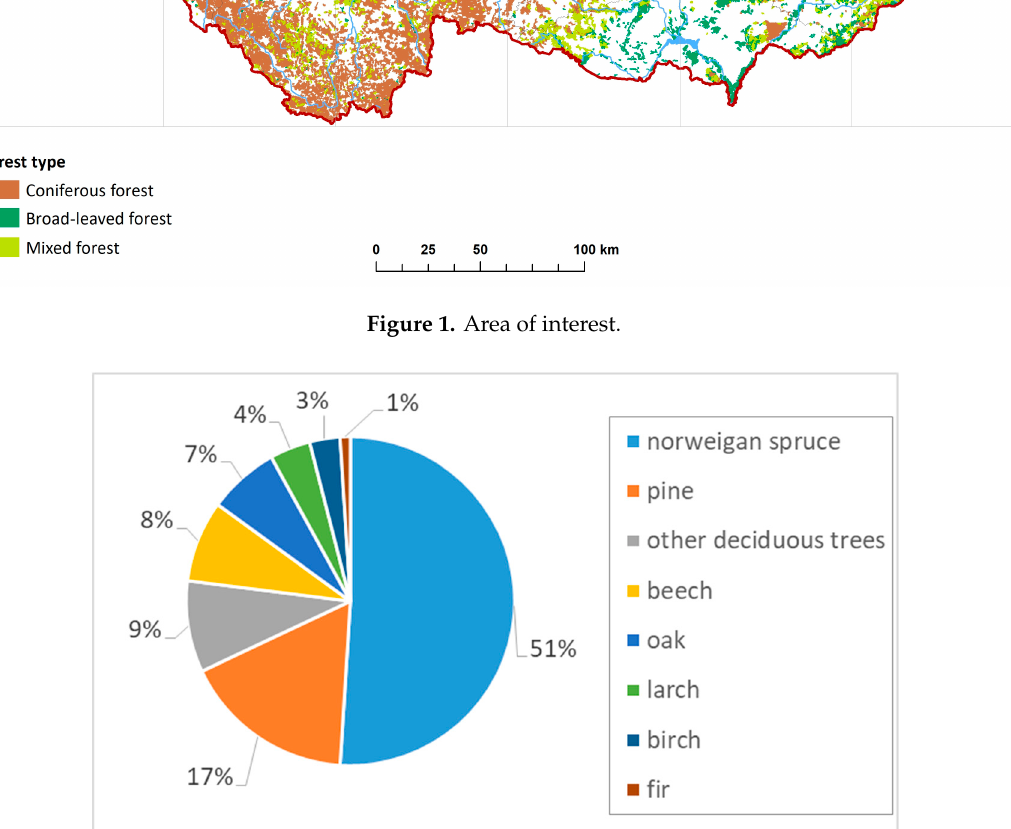
Figure 2. Species composition of forests in the Czech Republic; data source: Forest Management Institute.